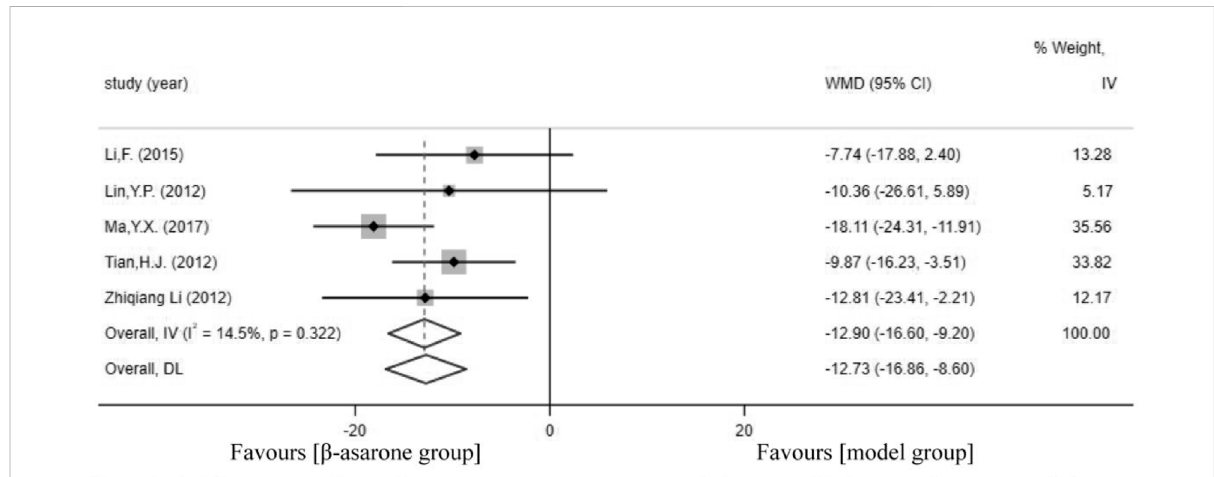
FIGURE 10 Forest plot for comparison: β -asarone group versus model group. Outcome: escape latency.